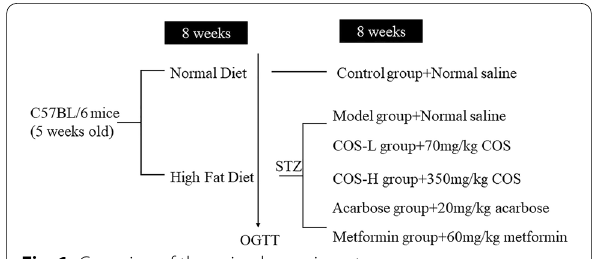
Fig. 1 Grouping of the animal